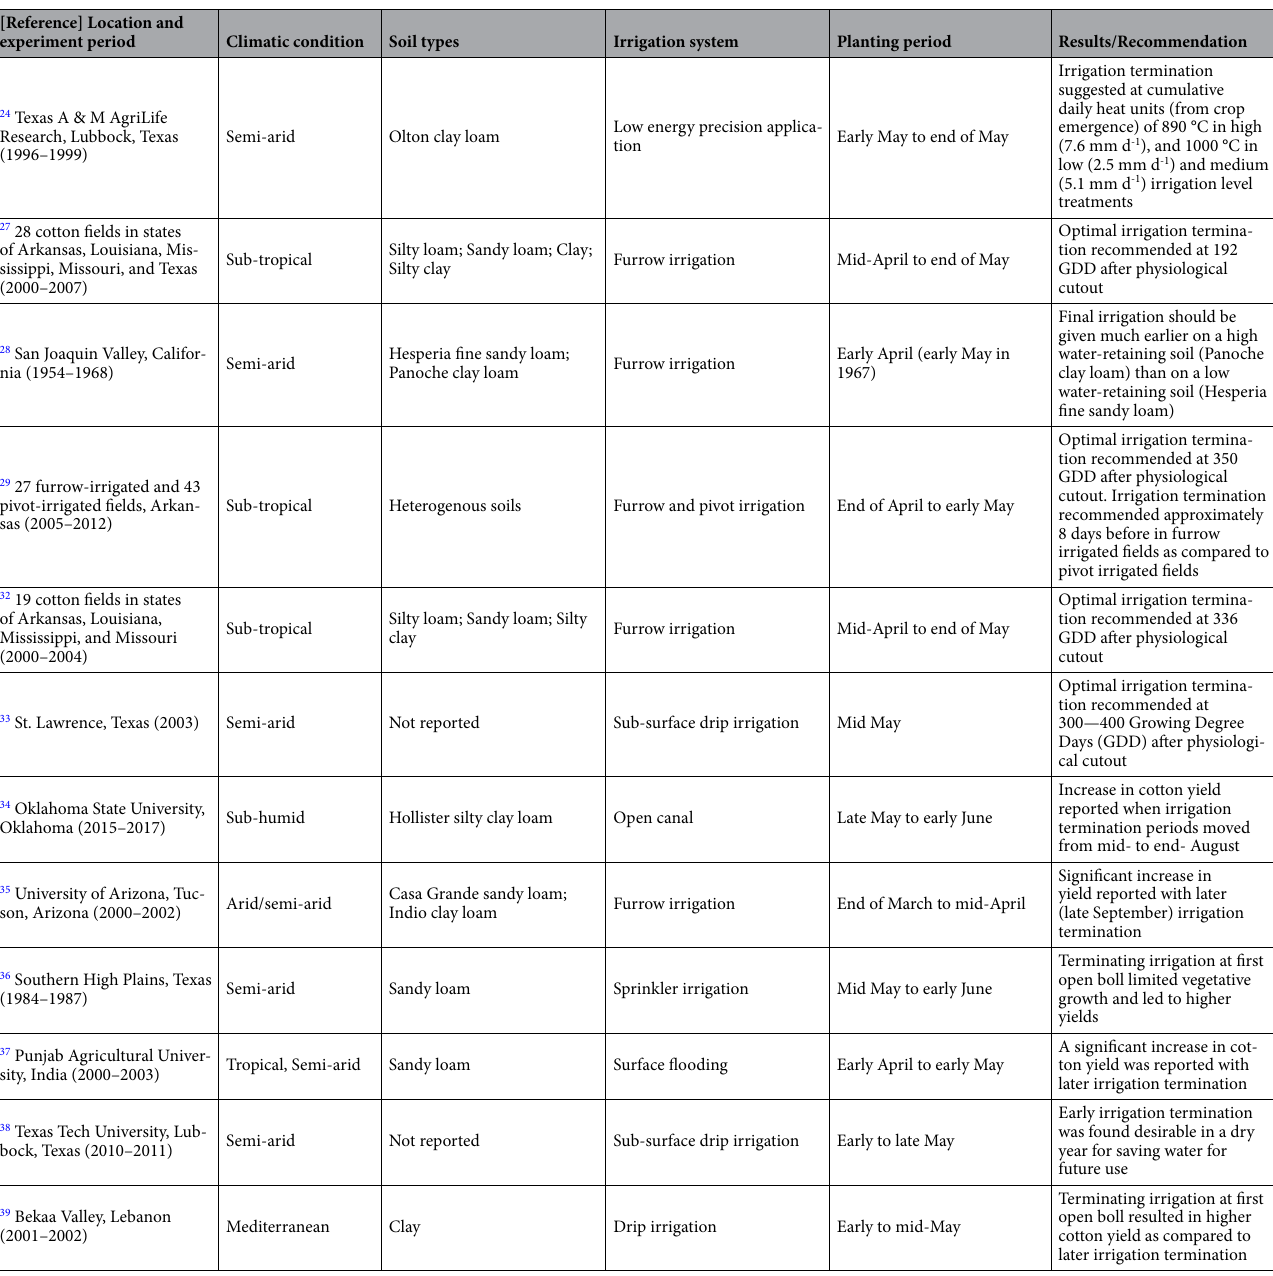
Table 1. Previous recommendations on irrigation termination periods for cotton based on different field